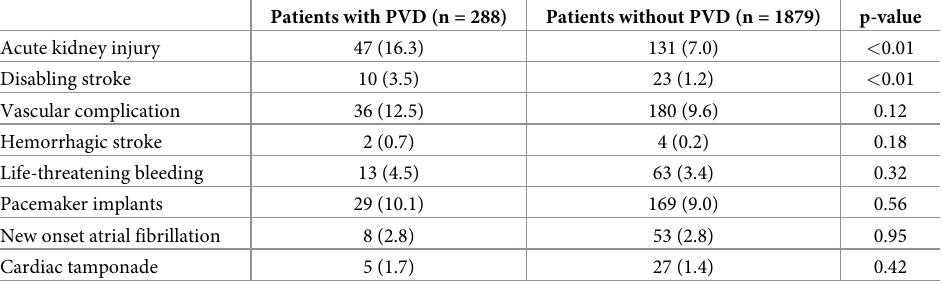
Table 2. In-hospital complications. Patients with PVD (n = 288) Patients without PVD (n = 1879) p-value Acute kidney injury 47 (16.3) 131 (7.0)